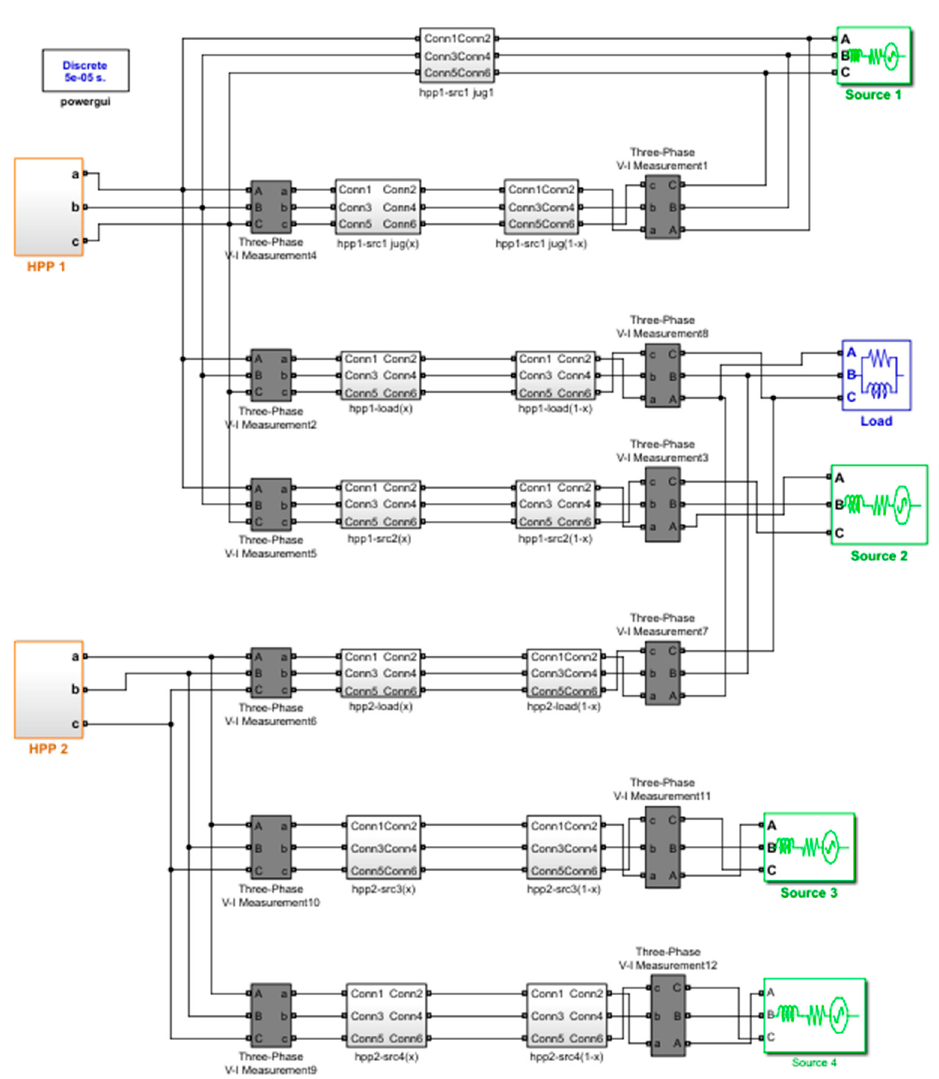
Figure 7. Network model for simulations in MATLAB/Simulink. The influence of the short-circuit on the current-voltage conditions of the observed network was analyzed by simulating a three-phase short-circuit at the generator terminals in HPP 1, as shown in Figure 8. The three-phase fault block implemented a three-phase circuit breaker, where the opening and closing times were